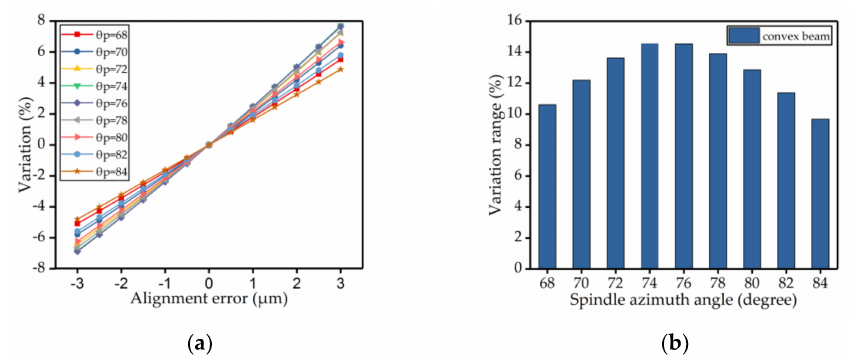
Figure 7. The influence of alignment errors on the spindle azimuth angle of the convex cross-section beam; ( a ) shows the relationship between the variation in the spindle azimuth angle and the alignment error; ( b ) shows the range in variation which is the absolute value of the difference between the maximum and minimum value of each spindle azimuth angle.